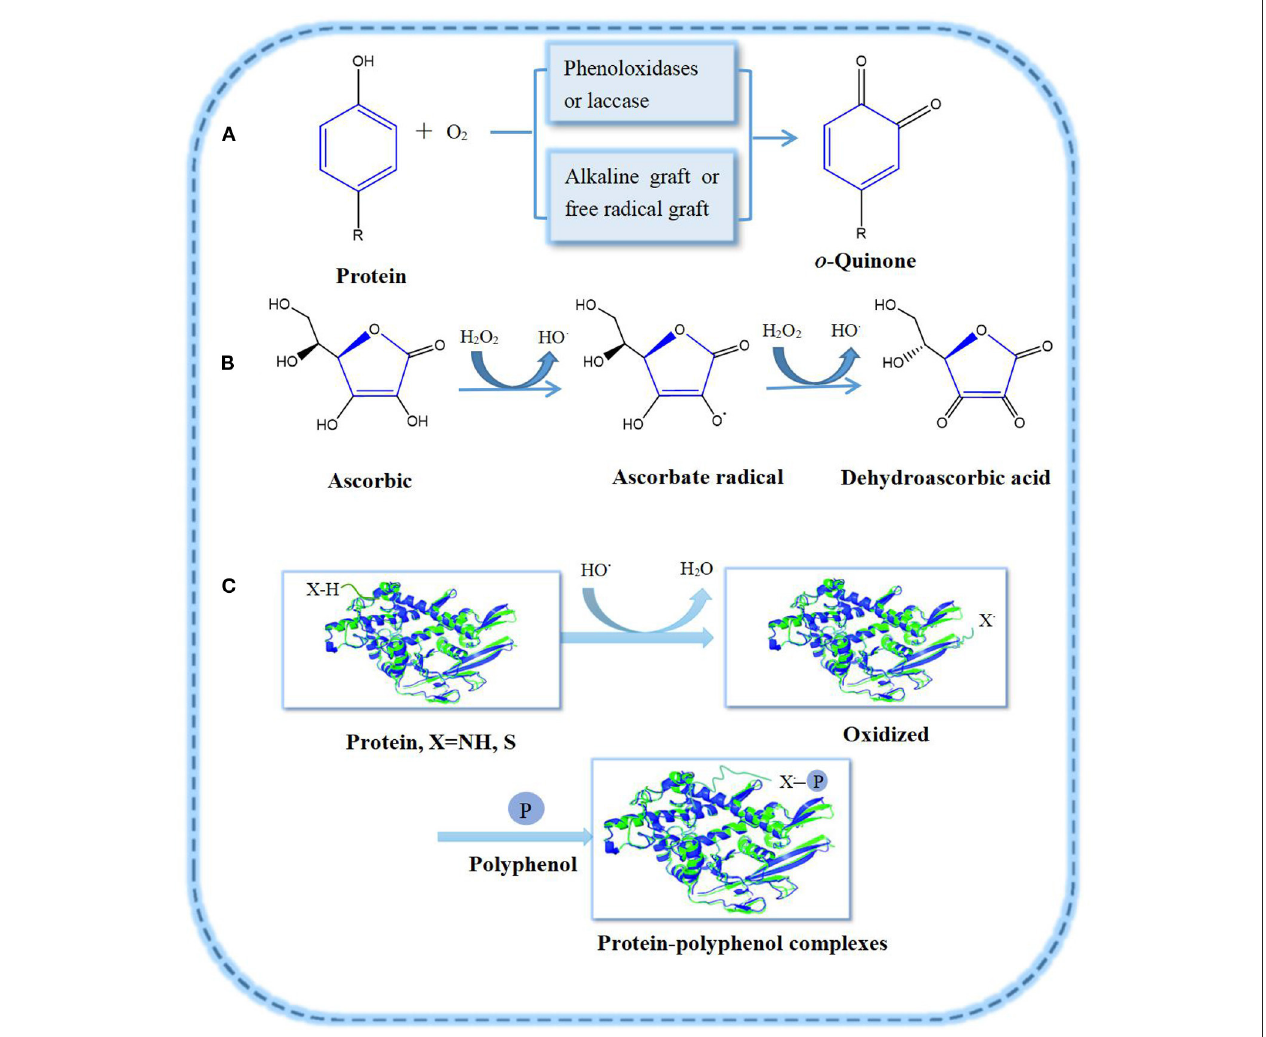
FIGURE 1 | Oxidation of polyphenols and their covalent graft reactions with proteins: (A) Polyphenol oxidation pathway; (B) Ascorbic acid oxidation system; (C) Protein-polyphenol radical grafting reaction.